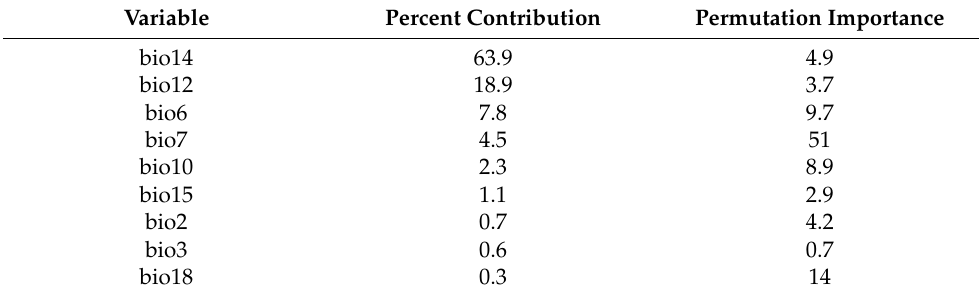
Table 2. Percentage contribution and permutation importance of the predictor variables to the MaxEnt